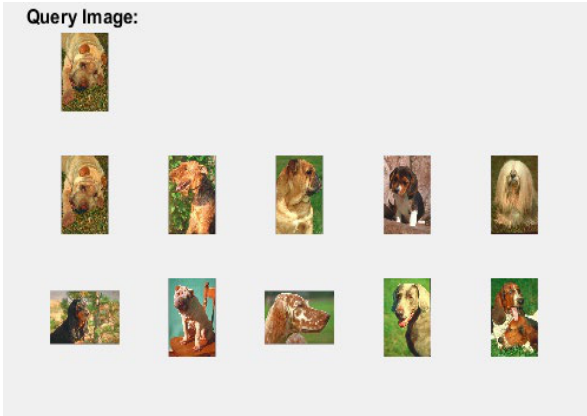
Figure 16. Top 10 images retrieved by the proposed method from Corel 5K